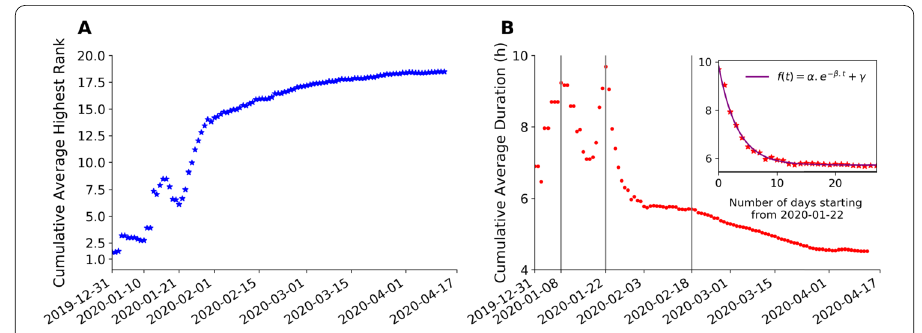
Figure 5 Attention decay. ( A ) Cumulative average highest rank of COVID-hashtags whose first appearance was in the time interval since December 31, 2019. ( B ) Cumulative average duration (hours). The inset shows a three-parameter exponential fit ( α = 4.13 h, β = 0.31 h/day, γ = 5.72 h) for the cumulative average duration decay after January 22,